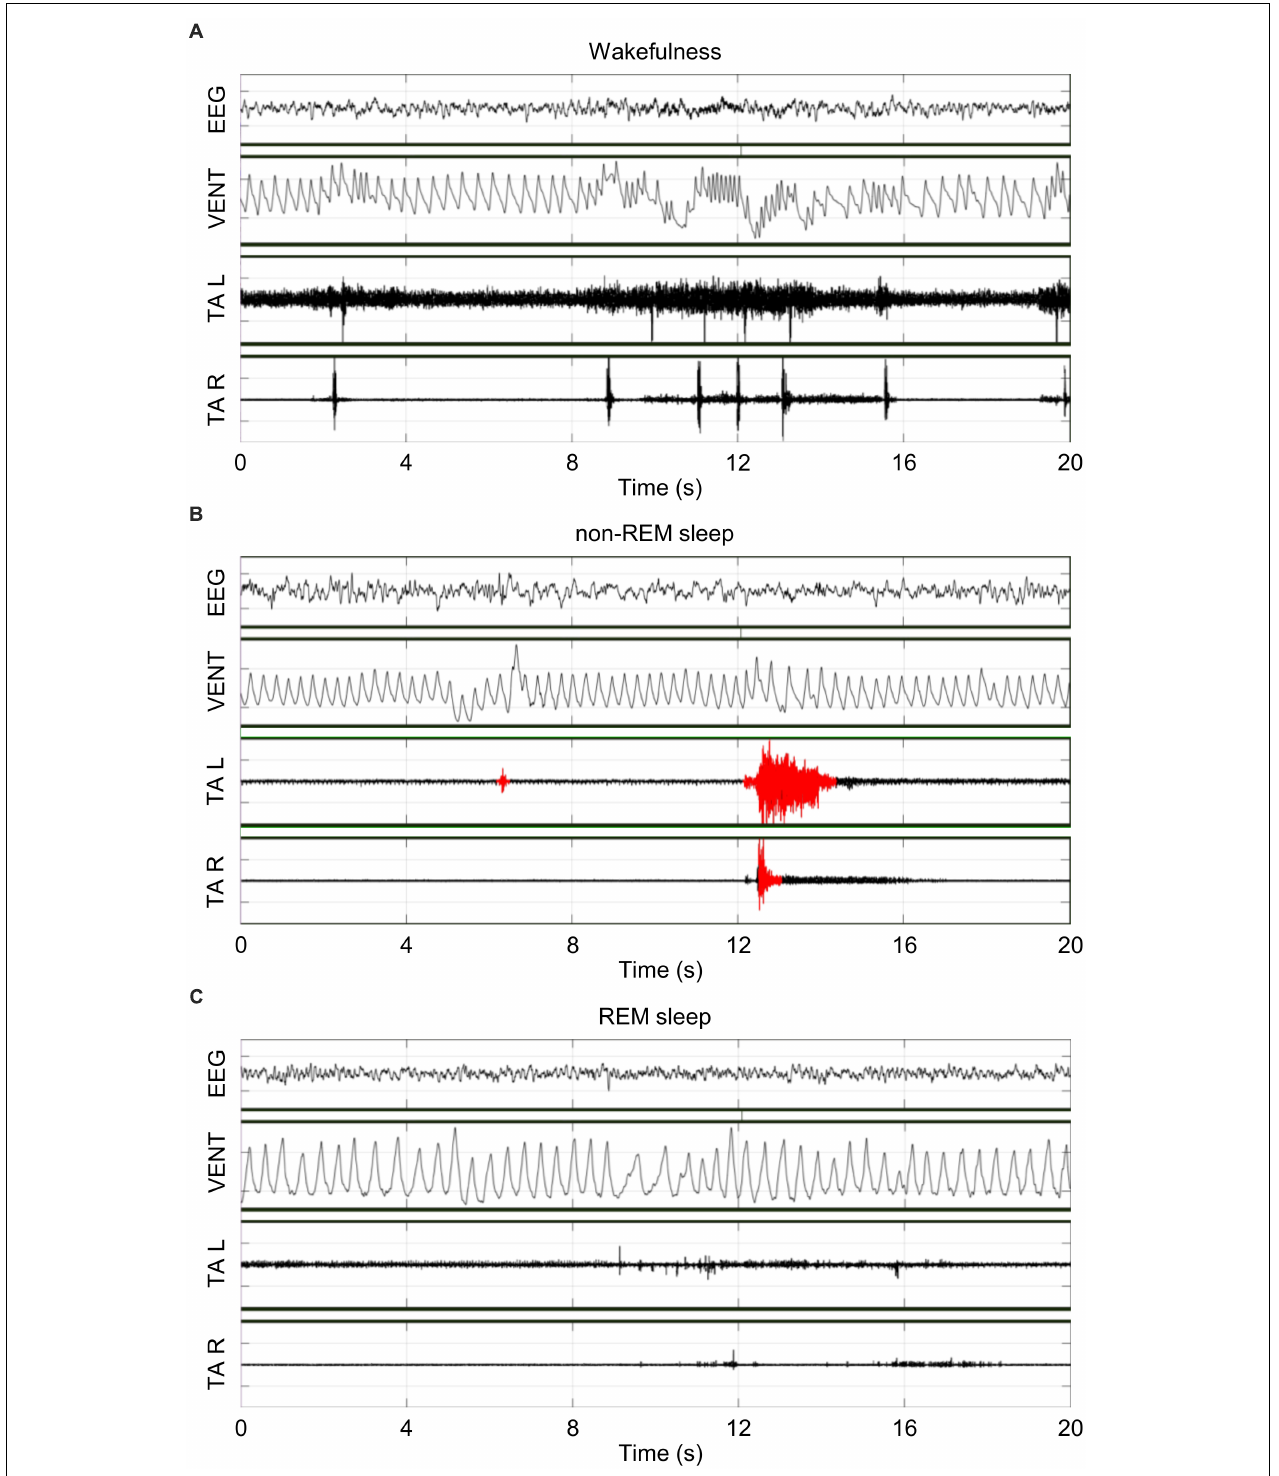
FIGURE 1 | Representative raw tracings of the electroencephalogram (EEG), the raw ventilation signal yielded by the whole-body plethysmograph (VENT), and the left (L) and right (R) electromyogram (EMG) of tibialis anterior (TA) muscles during wakefulness (A) , non-rapid-eye-movement (non-REM) sleep (B) , and rapid-eye-movement (REM) sleep (C) in the same iron-deficient mouse in conditions of hypoxia. Scoring of TA EMG bursts (red) was performed only in non-REM sleep.